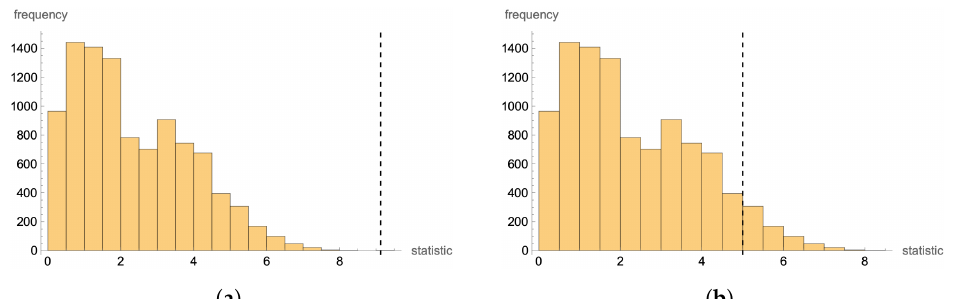
Figure 1. P-tests score significance by the position of d on actual data (represented as a vertical dashed line) against a distribution of statistic values generated by random permutations. ( a ) A position on the extreme tail shows significant difference. ( b ) A position within the distribution shows no significant difference.